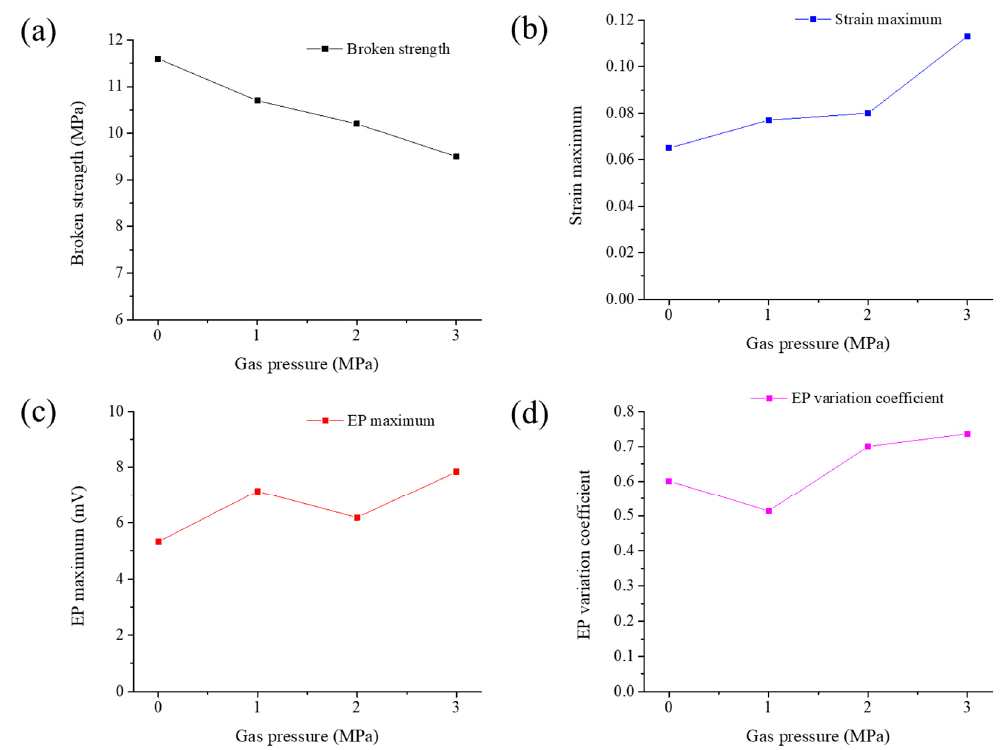
Figure 11. Statistical results of EP responses under different gas pressures. ( a ) Broken strength of specimen, ( b ) strain maximum of specimen, ( c ) EP maximum, ( d ) EP variation coefficient.